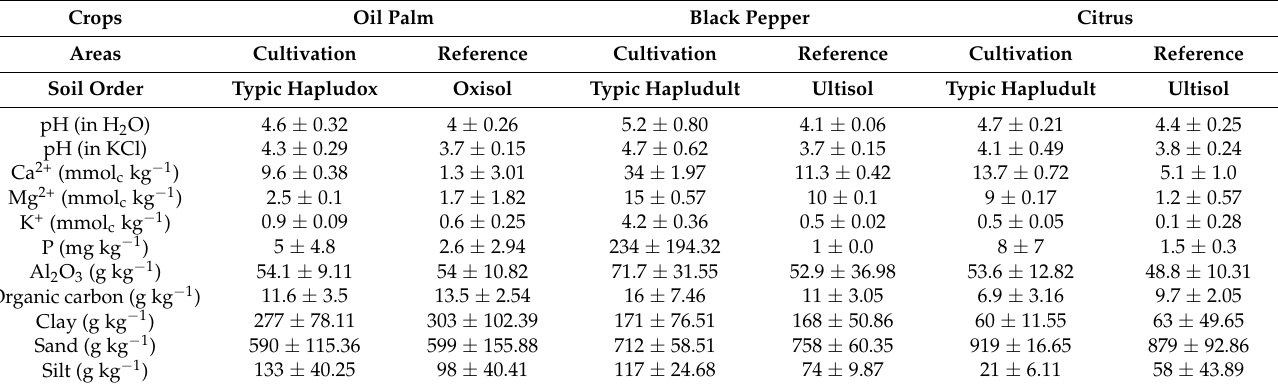
Table 1. Classification, chemical attributes and granulometry of the soils studied ( n =